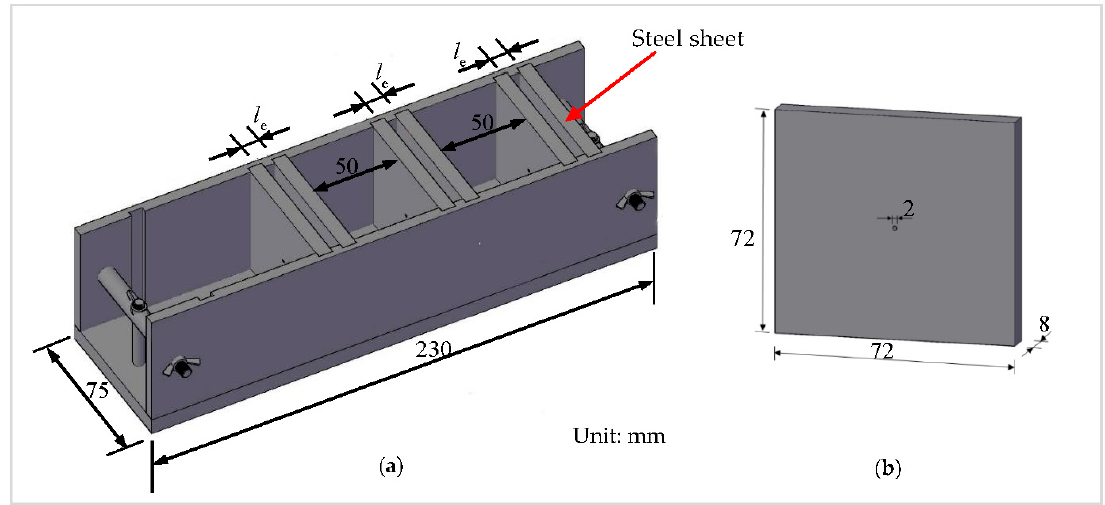
Figure 2. The steel mold of the fiber pull-out specimen: ( a ) steel mold, and ( b ) steel sheet.